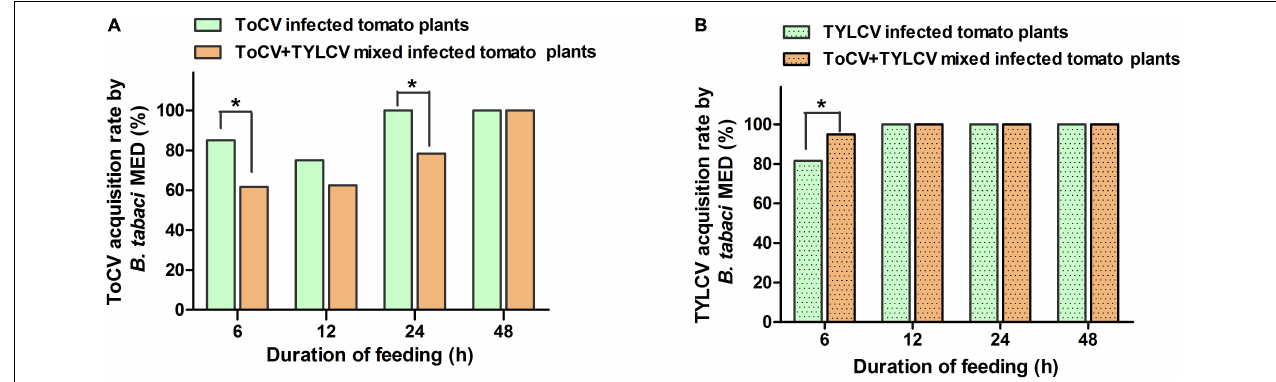
FIGURE 5 | Virus acquisition rates of Bemisia tabaci feeding on virus infected tomato plants at different time. (A) Tomato chlorosis virus (ToCV) acquisition rate of B. tabaci feeding on ToCV-infected and ToCV+TYLCV mixed infected plants. (B) Tomato yellow leaf curl virus (TYLCV) acquisition rate of B. tabaci feeding on TYLCV-infected and ToCV+TYLCV mixed infected plants. Asterisks indicate a significant difference between single infection and mixed infection (chi square test, P < 0.05).